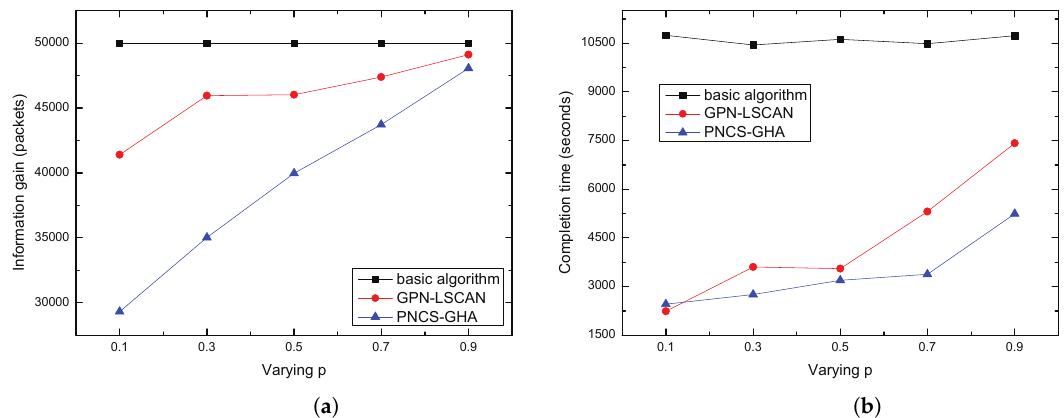
Figure 7. ( a ) Average information gain VS p ; ( b ) Average completion time VS p .